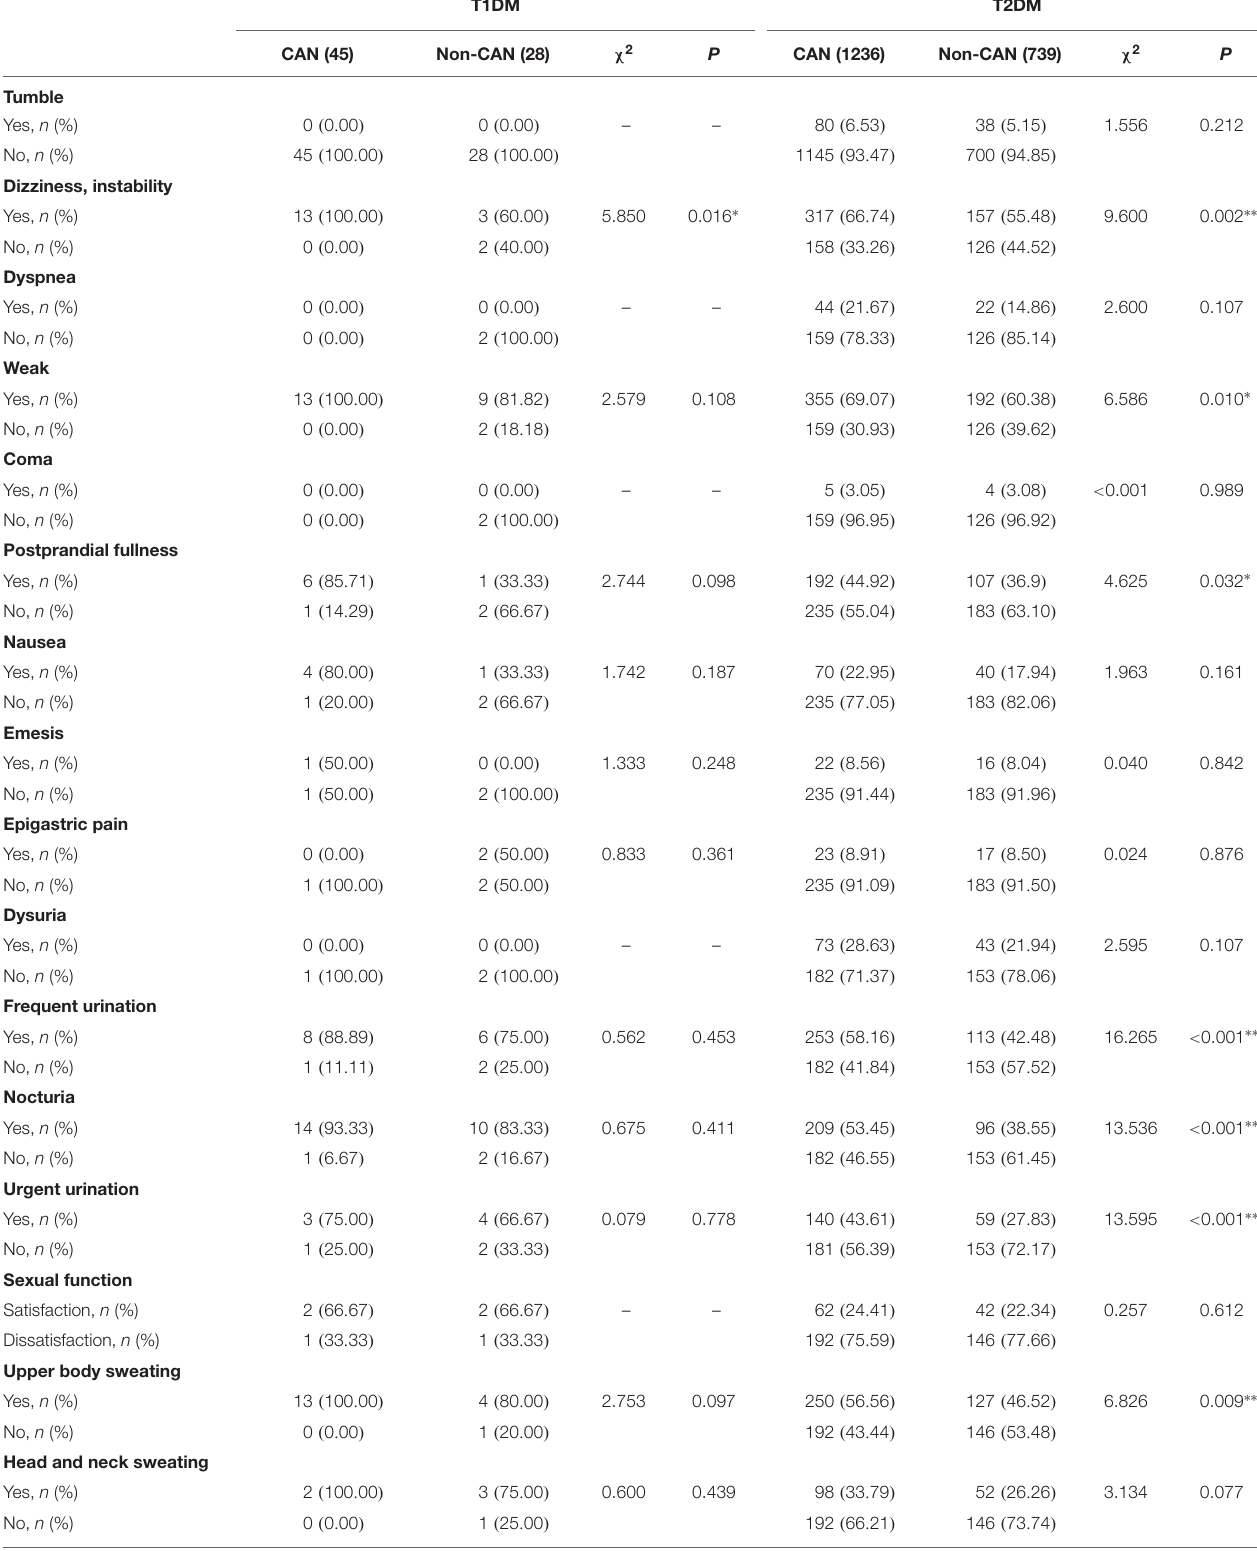
TABLE 3 | Symptoms of T1DM and T2DM groups by CAN